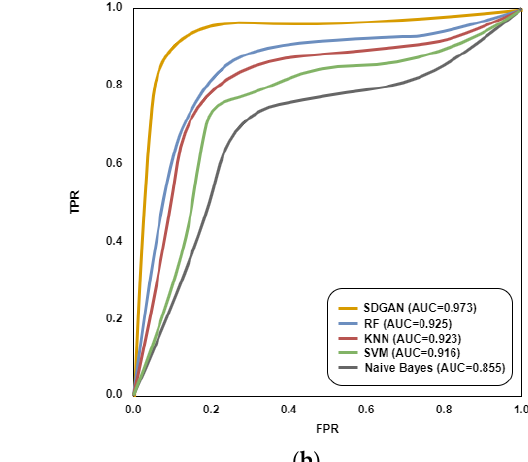
Table 6. Network configuration of CycleGAN generating system.